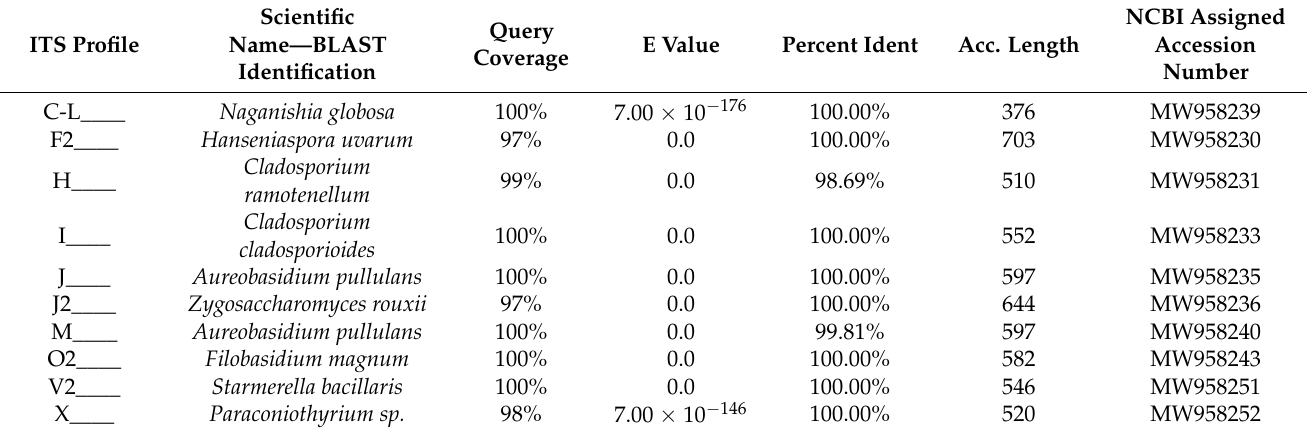
Table 1. Molecular characterization of fungal